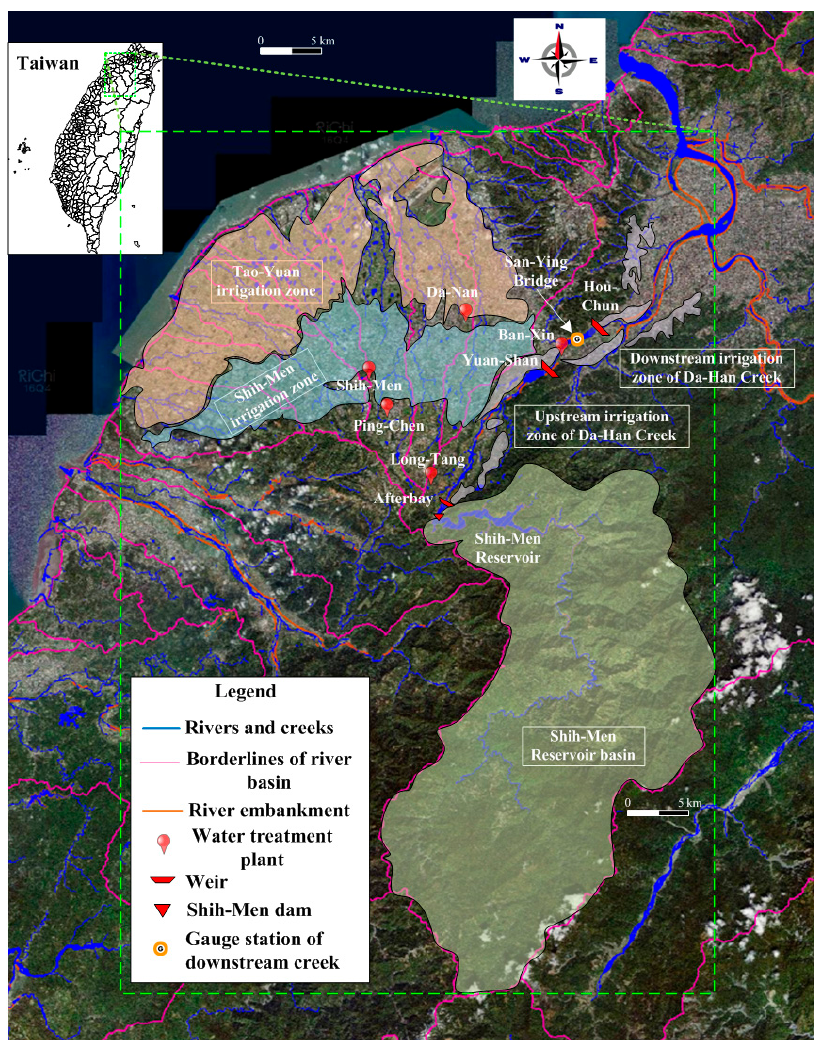
Figure 1. Map of the study area at Da-Han Creek basin.